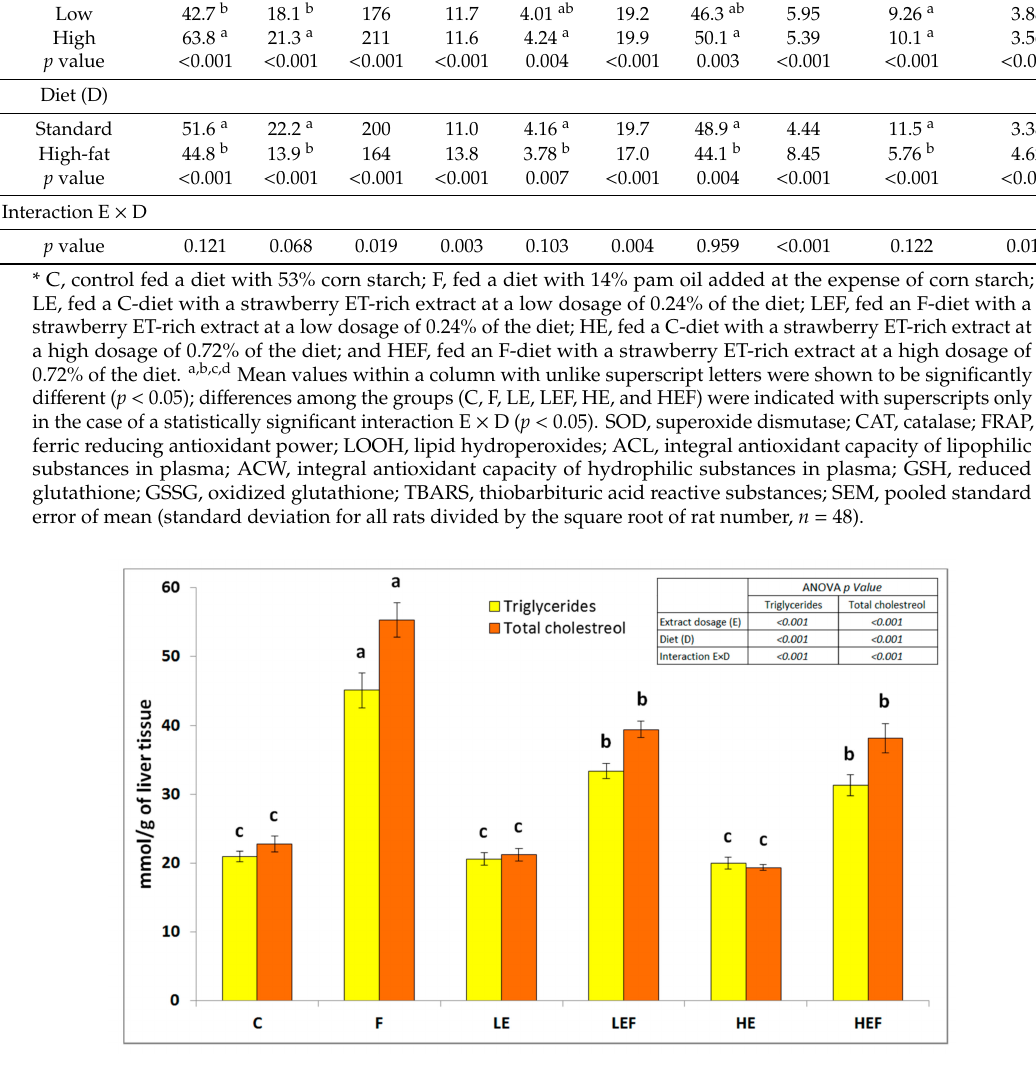
Figure 2. The hepatic level of cholesterol and triglycerides of rats fed the experimental diets: the values are the means ± SEMs. Mean values not sharing the same superscript letter within bars (a, b, or c) are di ff erent at p < 0.05. C, control fed a diet with 53% corn starch; F, fed a diet with 14% pam oil added at the expense of corn starch; LE, fed a C-diet with a strawberry ET-rich extract at a low dosage of 0.24% of the diet; LEF, fed an F-diet with a strawberry ET-rich extract at a low dosage of 0.24% of the diet; HE, fed a C-diet with a strawberry ET-rich extract at a high dosage of 0.72% of the diet; and HEF, fed an F-diet with a strawberry ET-rich extract at a high dosage of 0.72% of the